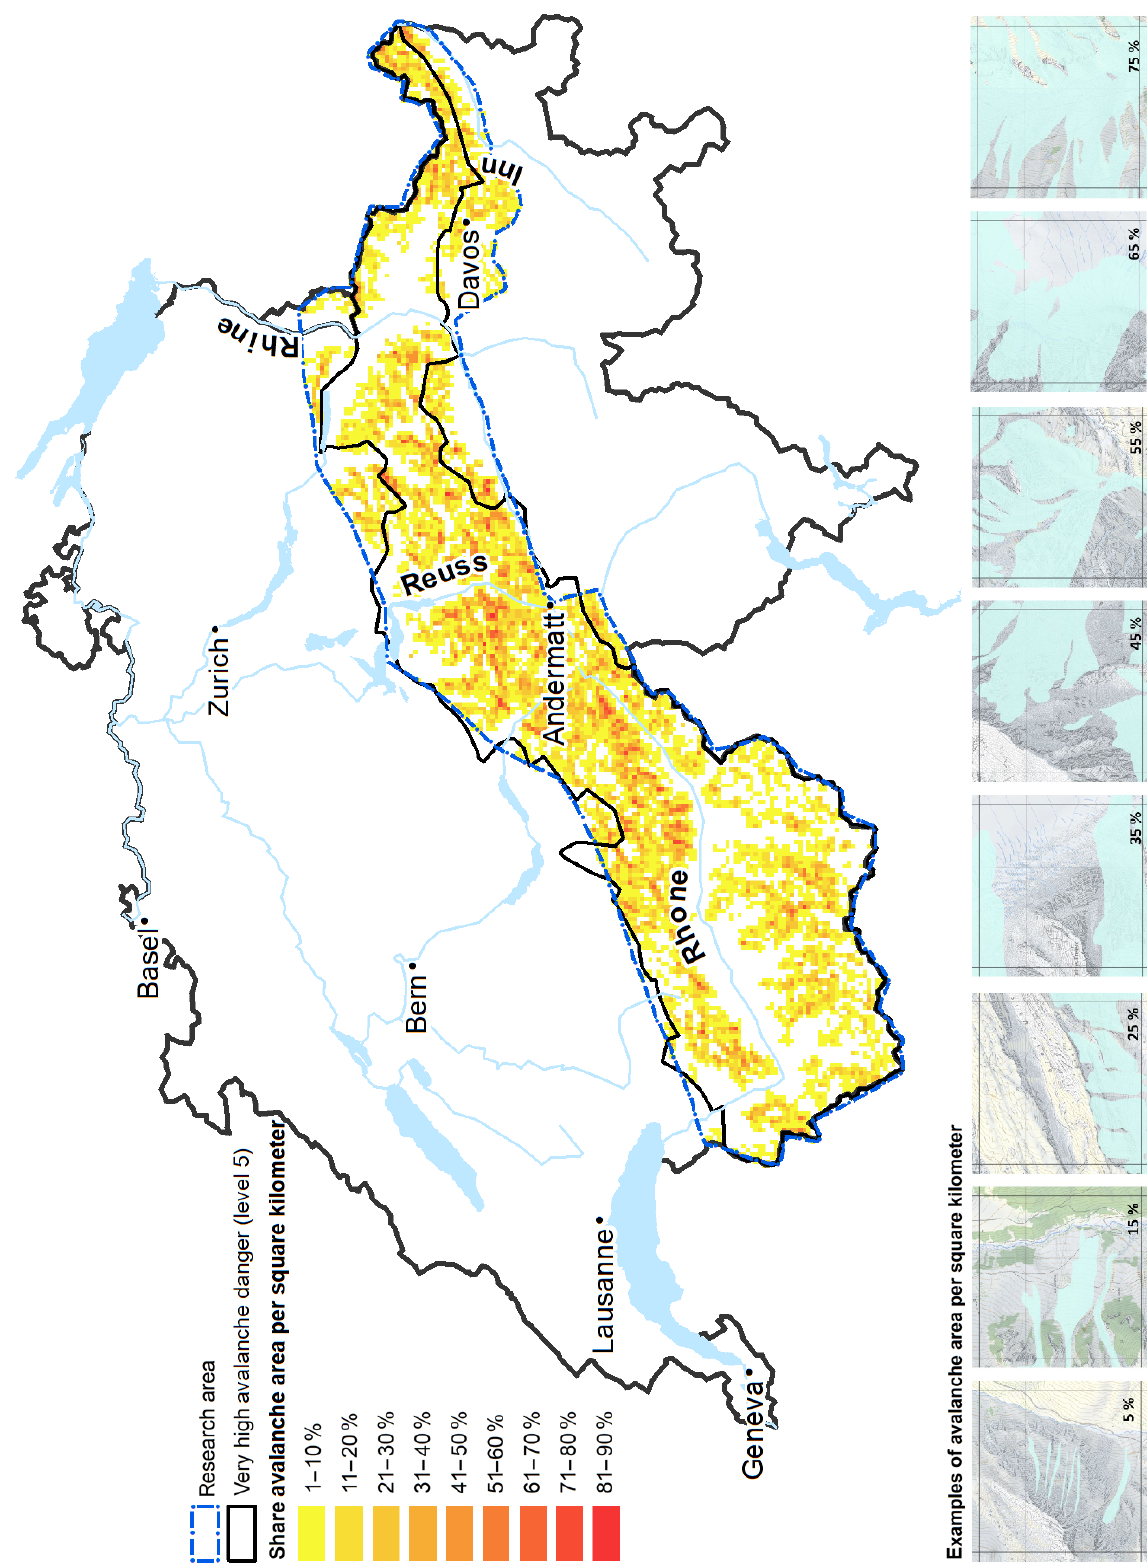
Figure 3. Avalanche density per square kilometer. Pixmap © 2019 swisstopo (5704000000), reproduced by permission of swisstopo